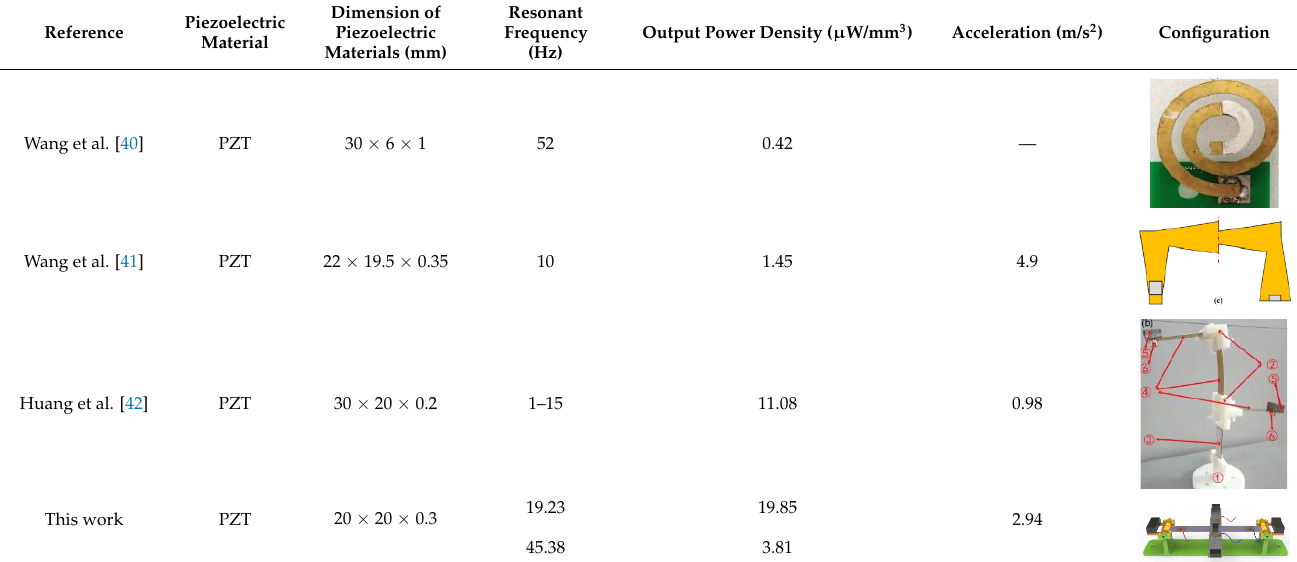
Table 2. Comparison of the harvesting performance of this work with the other researches.